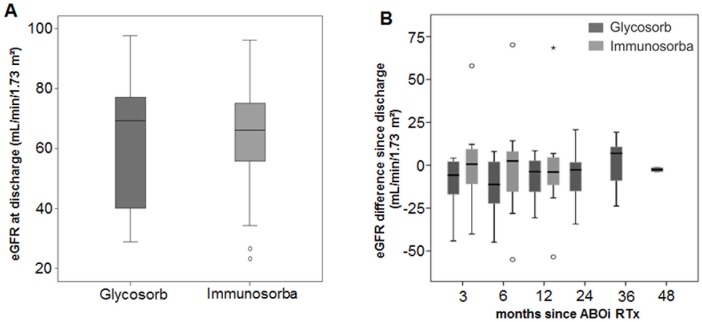
Comparison of renal function in both procedures.(A) The renal function (eGFR values calculated by MDRD) of patients who underwent antigen-specific and non-antigen-specific IA did not differ when patients were discharged from our hospital (p = 0.643). (B) During a 12 months follow-up, the eGFR of both IA groups revealed no noticeable differences from the baseline eGFR or between the IA groups (p = 0.185). °mild outliers; *extreme outliers.